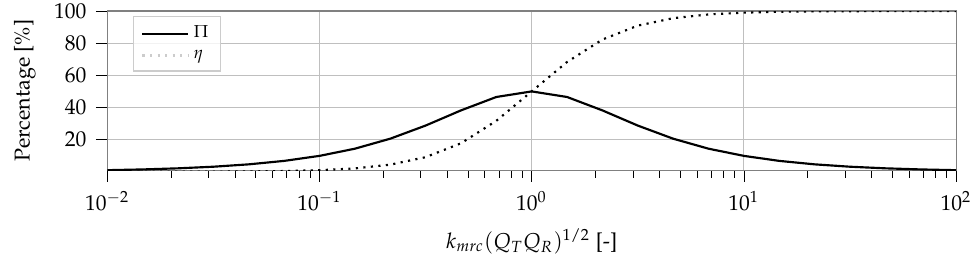
Figure 9. The transfer coefficient Π and efficiency η as function of k mrc ( Q T Q R ) 1/2